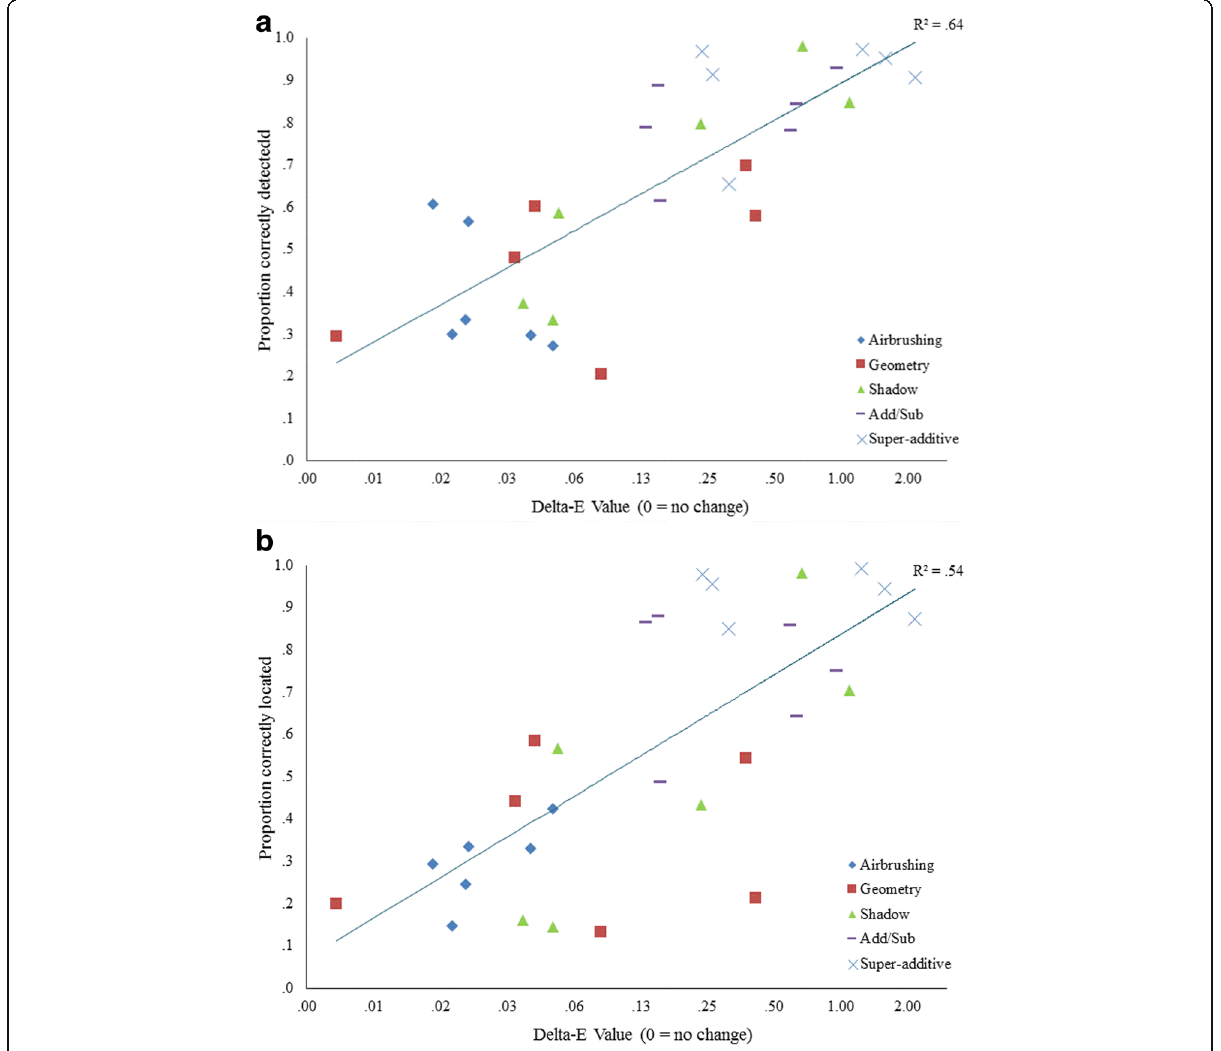
Fig. 8 Mean proportion of correctly detected ( a ) and located ( b ) image manipulations by extent of pixel distortion as measured by Delta-E. The graphs show individual data points for each of the 30 manipulated